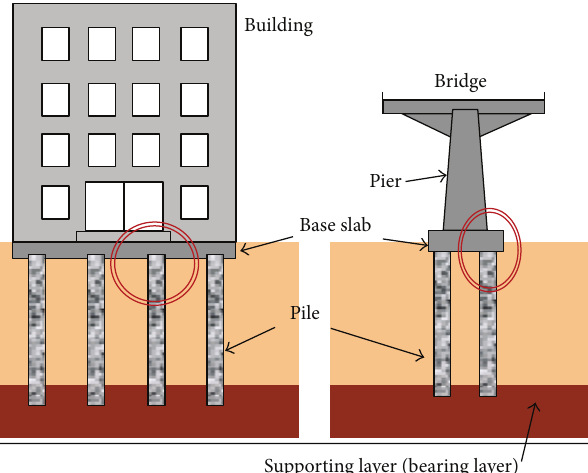
Figure 1: Connection between structural foundation and steel pile caps.